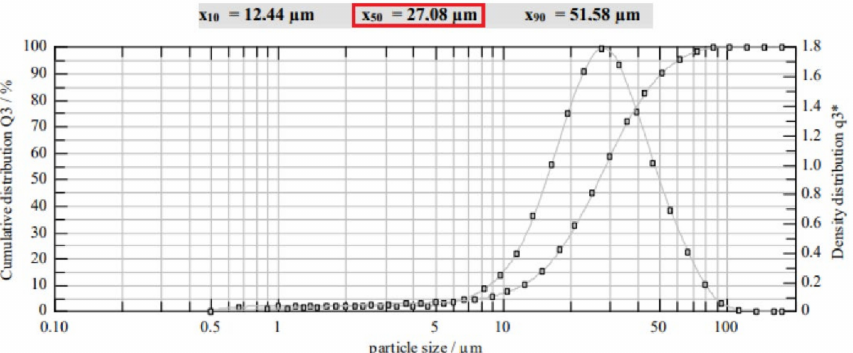
Figure 3. Exemplary distribution diagram of mean particle size distribution measured via spec- troscopy (laser scattering) showing cumulative and density distributions for one sample of the grain-size fraction <20 µ m. Measurement was repeated three times (see Table